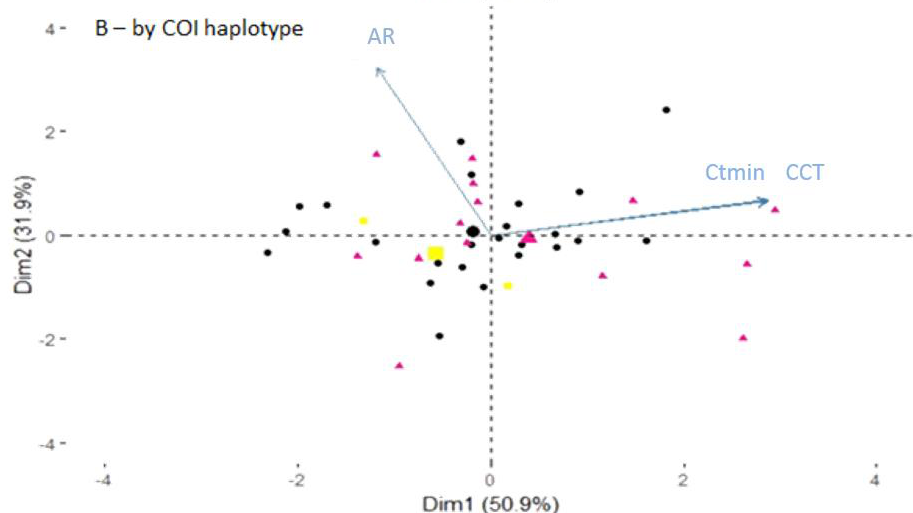
Figure 5. Principal component analysis (PCA) performed on the three thermal tolerance indices (CTmin, CCT, and AR). The PCA was performed after the normalization of the three variables. The projected inertia is provided for each axis. ( A ) Visualization according the origin of the strains. Red circles, blue triangles, and green squares, respectively, represent southern meso-Mediterranean, southern supra-Mediterranean, and northwestern strains, bigger symbols indicate the mean position for each origin. The dotted ellipse includes southern strains with highest values on the first axis of the PCA. ( B ) Visualization according the molecular characterization. Black circles, pink triangles, and yellow squares, respectively, represent cluster 1, cluster 2, and other haplotypes (see Figure 1), bigger symbols indicate the mean position for each haplotype.